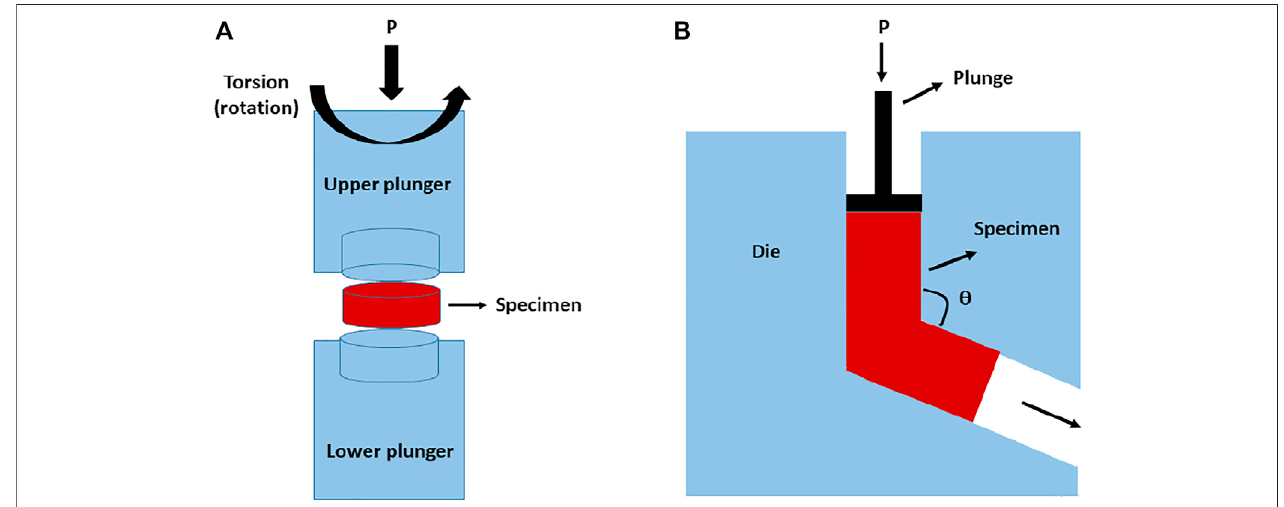
FIGURE 1 | Schematic presentation of the (A) high-pressure torsion (HPT) and (B) equal channel angular pressing (ECAP).